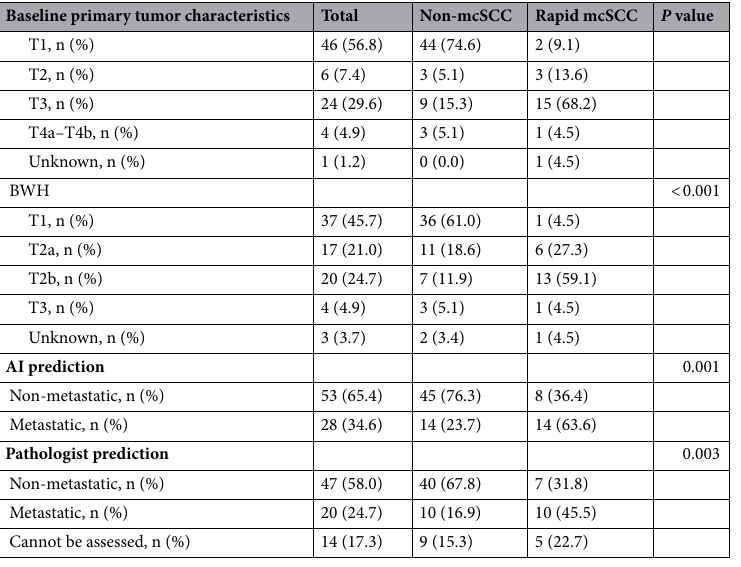
Table 1. Clinicopathological primary tumor characteristics of the final cohorts utilized in the rapid metastasis -AI-model (tumor n = 81). AI: artificial intelligence; AJCC-8: the 8th edition of American Joint Committee on Cancer; BWH: Brigham and Women’s Hospital; IQR: interquartile range; mcSCC: primary metastatic squamous cell carcinoma; WSI: whole slide